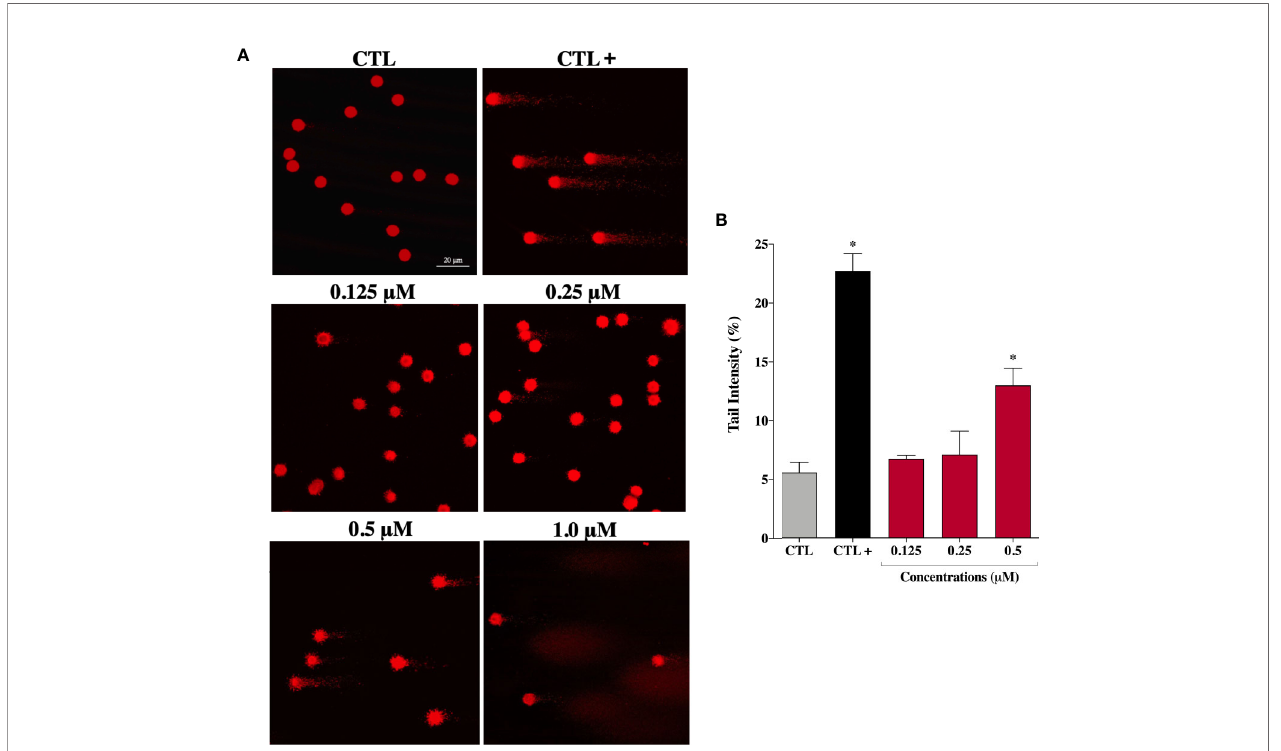
FIGURE 6 | Genotoxic effect of ruthenium complex ( 2 ) in DU-145 cells. (A) Representative image samples obtained by application of alkaline version of comet assay on DU-145 cells treated with complex ( 2 ) at 0.125, 0.25, 0.5, and 1.0 m M for 24 h. (B) Bar graph represents the tail intensity (%), which is directly correlated to damage DNA. The images were acquired with fl uorescence microscopy at a total magni fi cation of 400× (scale bar = 20 m m) and correspond to a representative assay from three independent experiments. The negative control (CTL) was treated with the vehicle (0.1% DMSO) used for diluting the tested compound and the positive control (CTL+) was treated with methyl methanesulfonate (150 m M). Data are presented as the mean ± S.E.M. of three independent experiments. * p < 0.05 compared with the control by ANOVA followed Dunnet ’ s test.